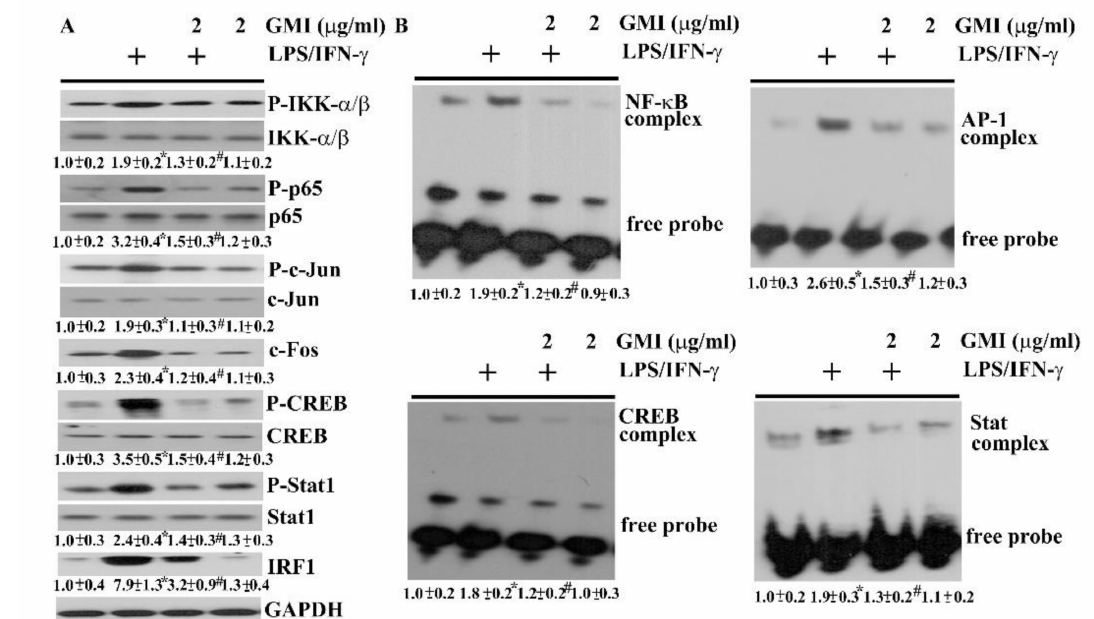
Figure 8. GMI alleviated transcription factor activation. Neuron/glia cultures were pretreated with vehicle or various concentrations of GMI (0.1 and 2 µ g/mL) for 30 min. before being incubated with LPS (100 ng/mL)/IFN- γ (10 U/mL) for an additional 4 h. Total cellular proteins were extracted and subjected to Western blot analysis with indicated antibodies ( A ). Nuclear proteins were extracted and subjected to EMSA for the measurement of NF- κ B, AP-1, CREB, and Stat1 DNA binding activities ( B ). One representative blot of four independent culture batches is shown and the fold of relative protein content or complex content is depicted under the blots. The protein content or complex content of untreated control was defined as 1.0. The + means the groups treated with LPS/IFN- γ and the rest groups without + indicate vehicle treatment. * p < 0.05 vs. untreated control and # p < 0.05 vs. LPS/IFN- γ